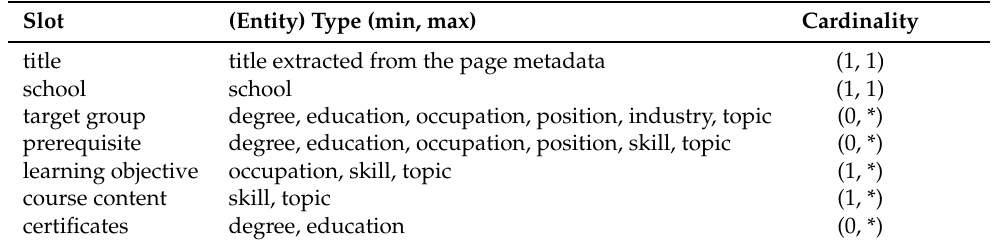
Figure 3. Snippet of an annotated example course description taken from https://www.sae.edu, accessed on 17 October 2022. Light blue highlighting indicates identified entities, and the red border outlines the page segment to which they have been assigned. Table 1. Target slot, valid entity types and cardinalities of course